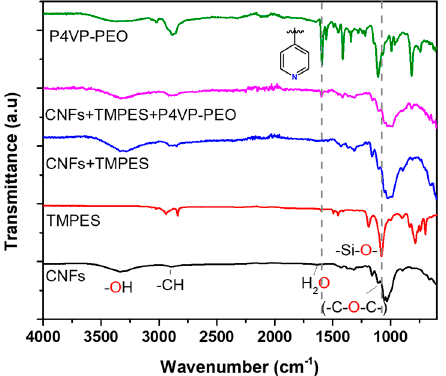
Figure 5. FTIR spectra of CNFs, TMPES, P4VP-PEO, CNFs + PEMS and CNFs + PEMS + P4VP-PEO.